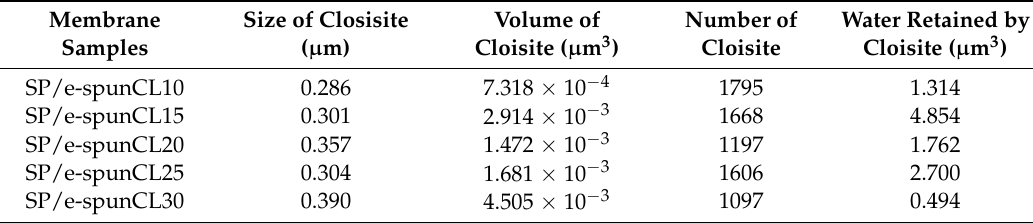
Table 4. Mean of cloisite size in every10 µ m 2 SP/e-spunCL